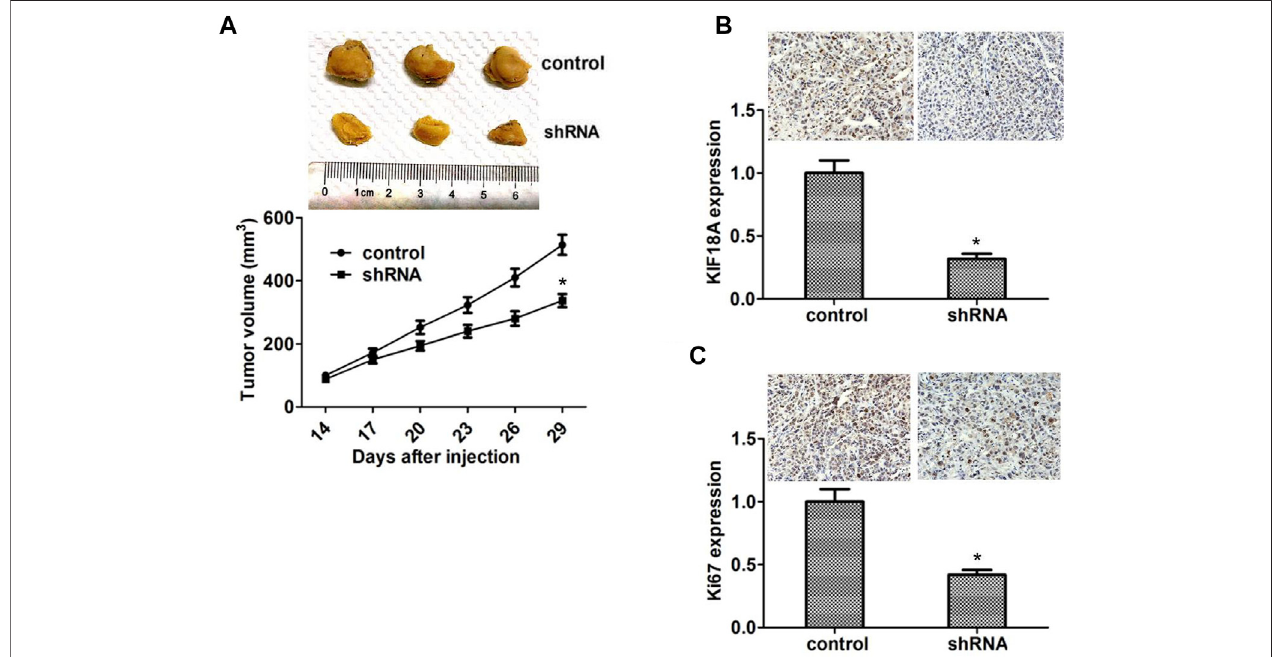
FIGURE6| KnockdownofKIF18AimpairedthetumorgrowthofGBMcellsinmice. (A) U87cellsinfectedwithKIF18AorshRNAcontrolplasmawererepopulated intonudemice.After2 weeks,tumorsweredrainedandtumor sizewasmeasured weekly( n =threegroups).Tumorgrowthcurvesestimatedthreetumors. (B) Analysis shows that KIF18A is expressed in control or non-KIF18A tumor tissue from mice. (C) IHC analysis shows that Ki67 is expressed in control tissues or tissues lacking KIF18A. Results are expressed as overall standard deviation, * p <